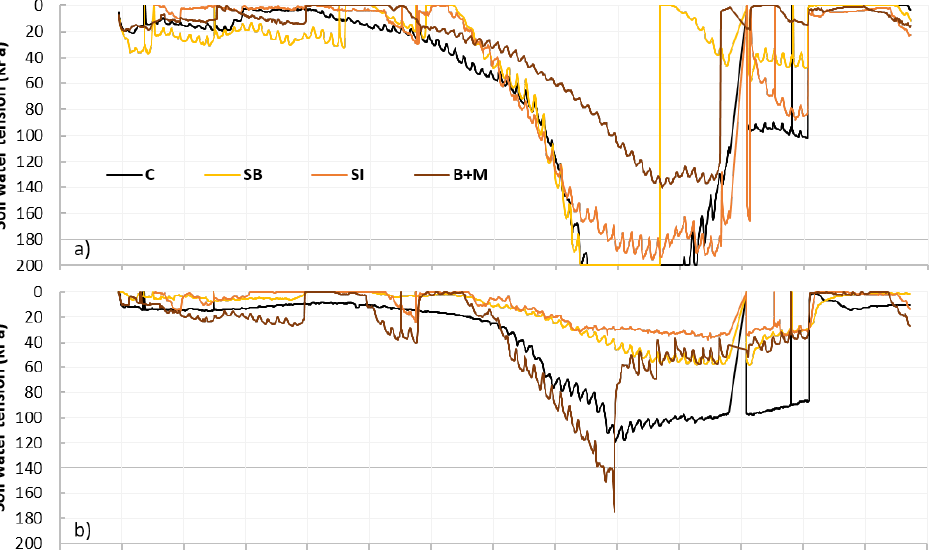
Figure 7. Soil water tension recorded in beds ( a ) and furrows ( b ) throughout the season in the four amendment treatments assessed in experiment 2: control (C, unamended), rice straw banded (SB), rice straw incorporated (SI) and manure plus biochar (B +